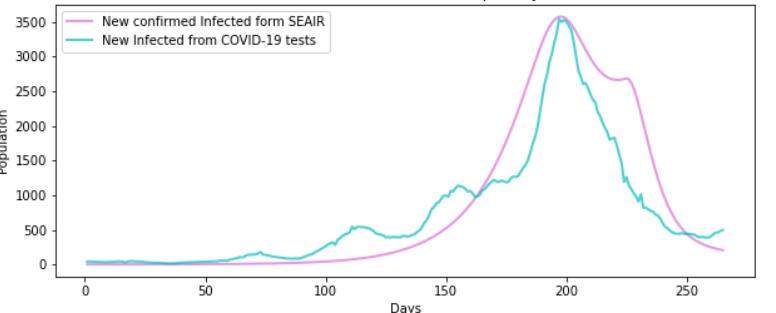
Figure 14. Comparison of newly infected people between SEAIR model and COVID-19 tests in Denmark’s second wave.